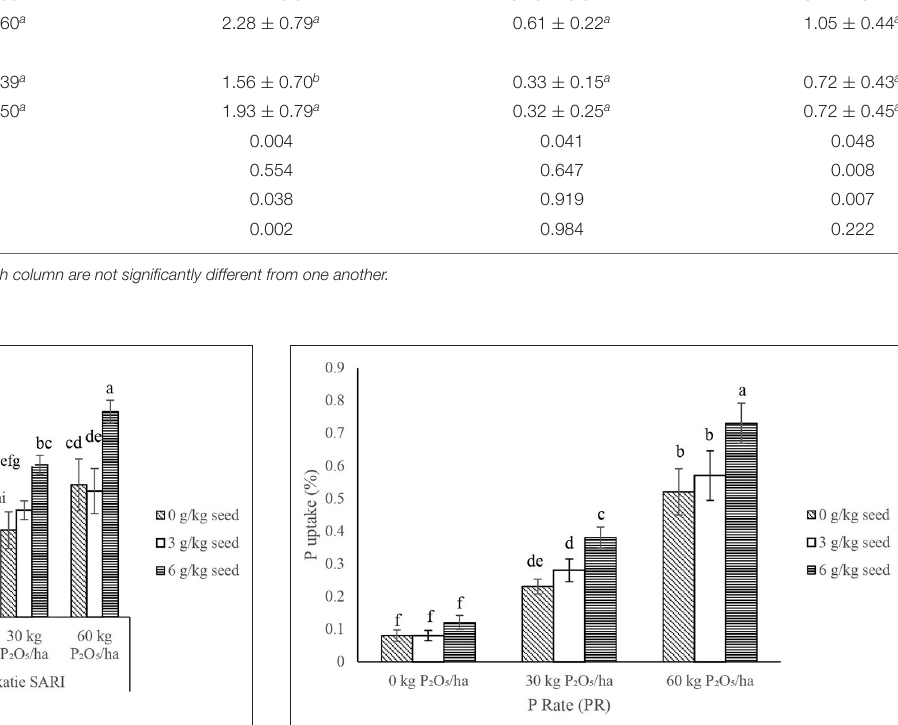
FIGURE 8 | Interactive effect of P-rate (PR), inoculant rate (IR), and variety (V) on N uptake of groundnut grown in Haplic Lixisols of northern Ghana. Bars with different letters (in horizontal direction) show significantly different means. Error bars represent standard error of mean.